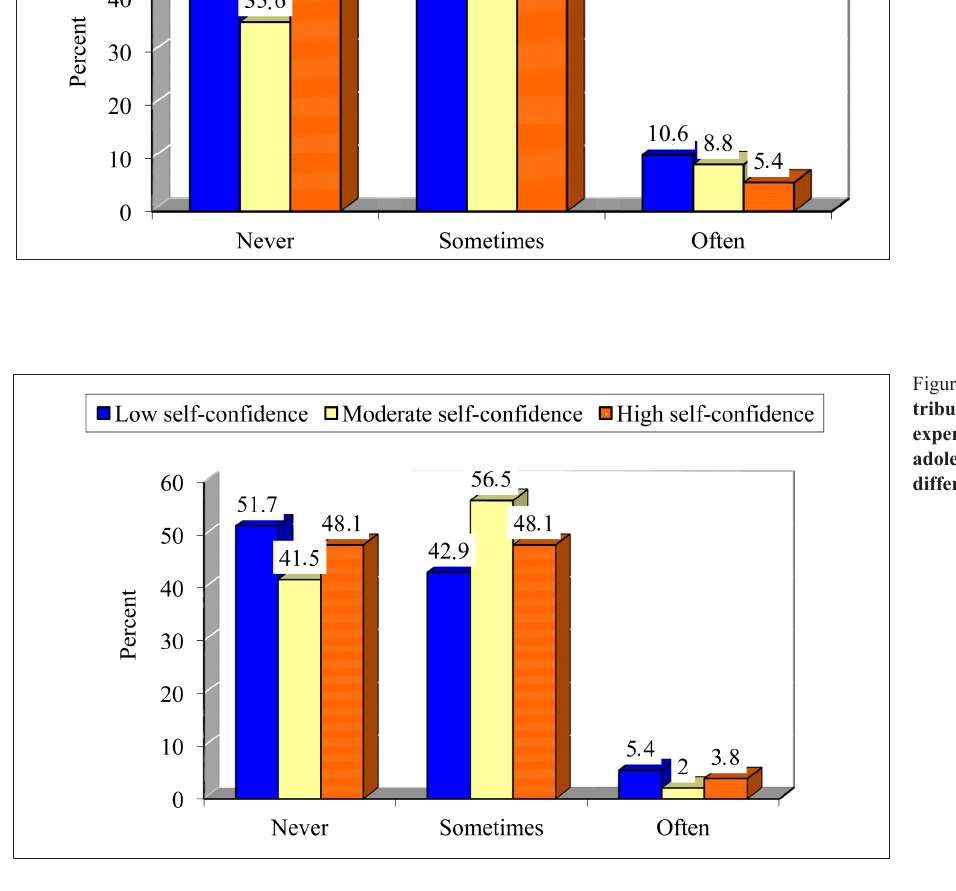
4 figure. Percentage distri- bution of bullying